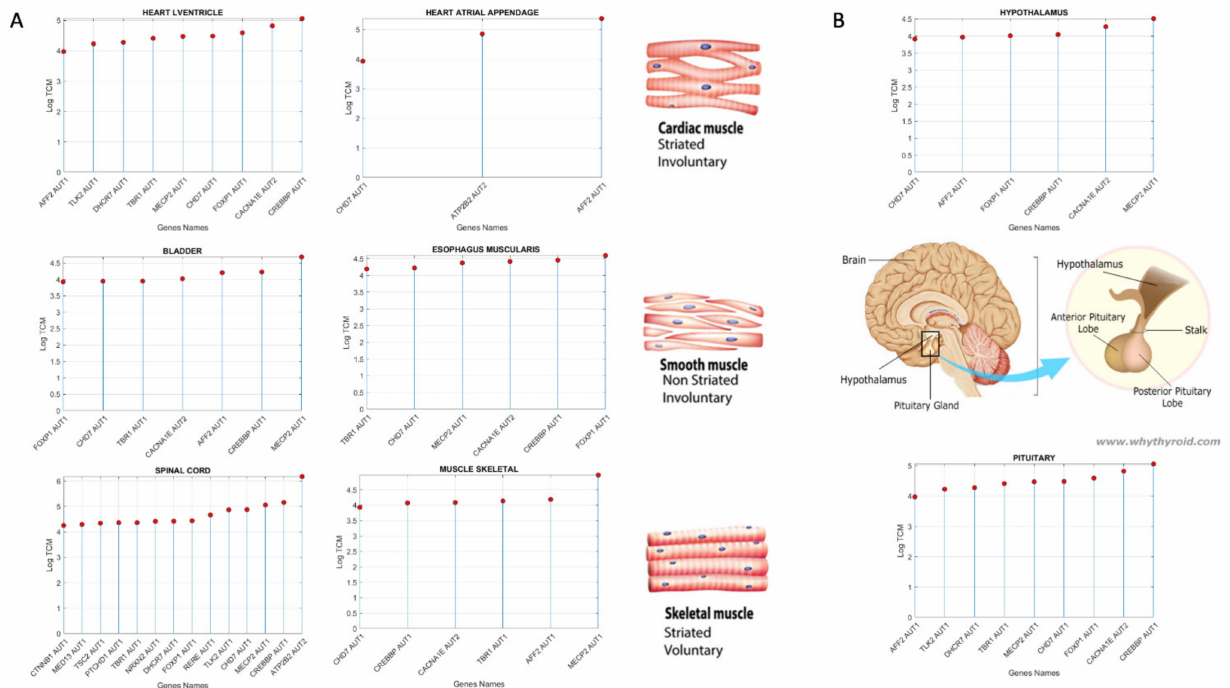
Figure 7. Genes present in Autism and all other neurological and neuropsychiatric disorders maximally expressed (above log(e 60 ) on tissues involved in all vital functions associated with cardiac, smooth, and skeletal muscles and the spinal cord ( A ), and with self-systemic regulation ( B ). Top genes and corresponding SFARI confidence score are also plotted on the horizontal axis. Vertical axis reflects the expression in log TCM units. Schematics reflect the locations of the hypothalamus and pituitary gland in the brain (from www.whythyroide.com) (accessed on 28 October